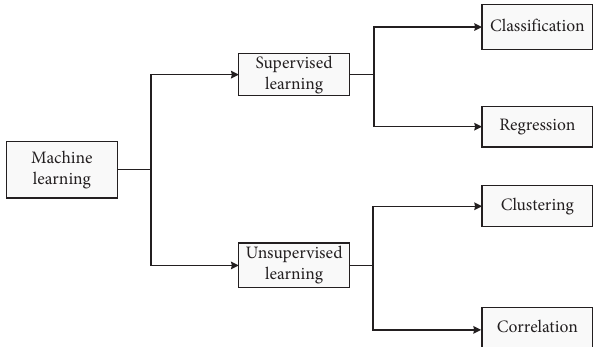
Figure 1: Composition structure of machine